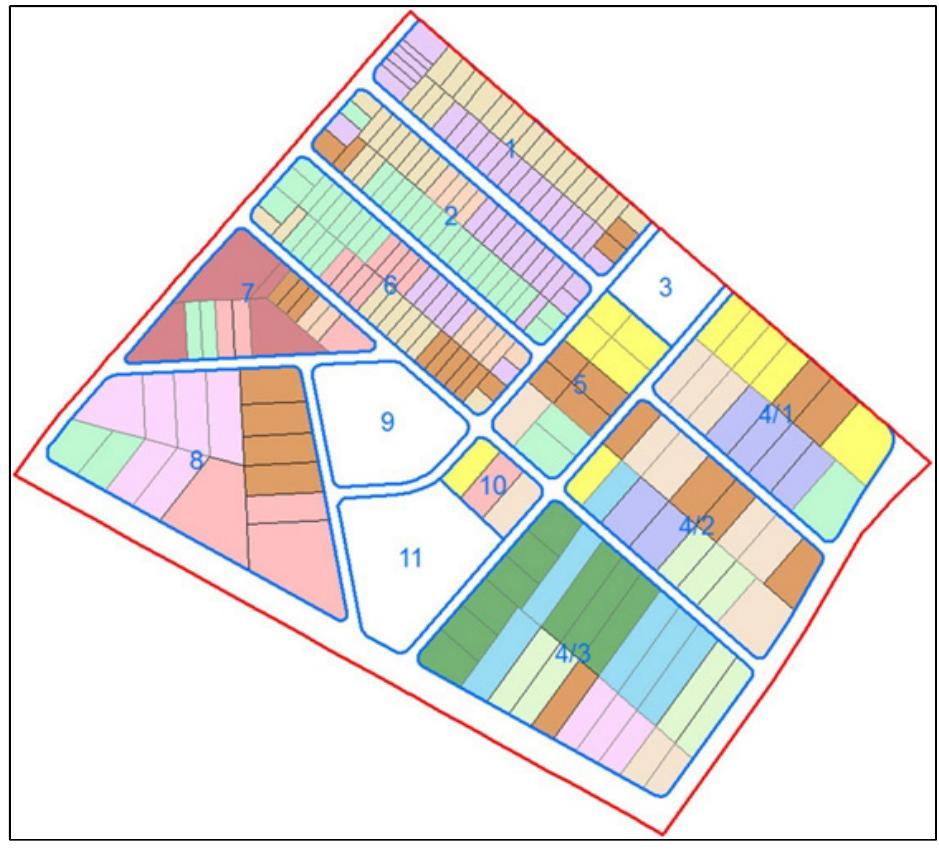
Figure 7. New plots on the LR area. Table 2. Summary of numeric data for LR